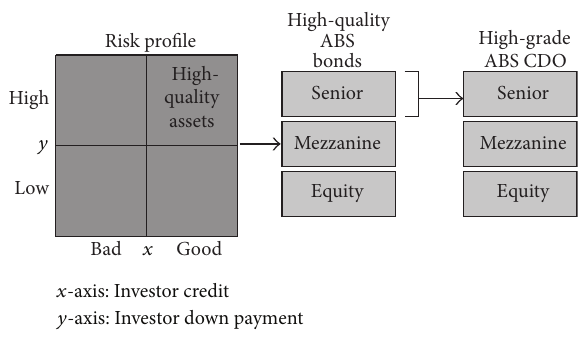
Figure 2: Chain of HQAs and their SAPs; source: